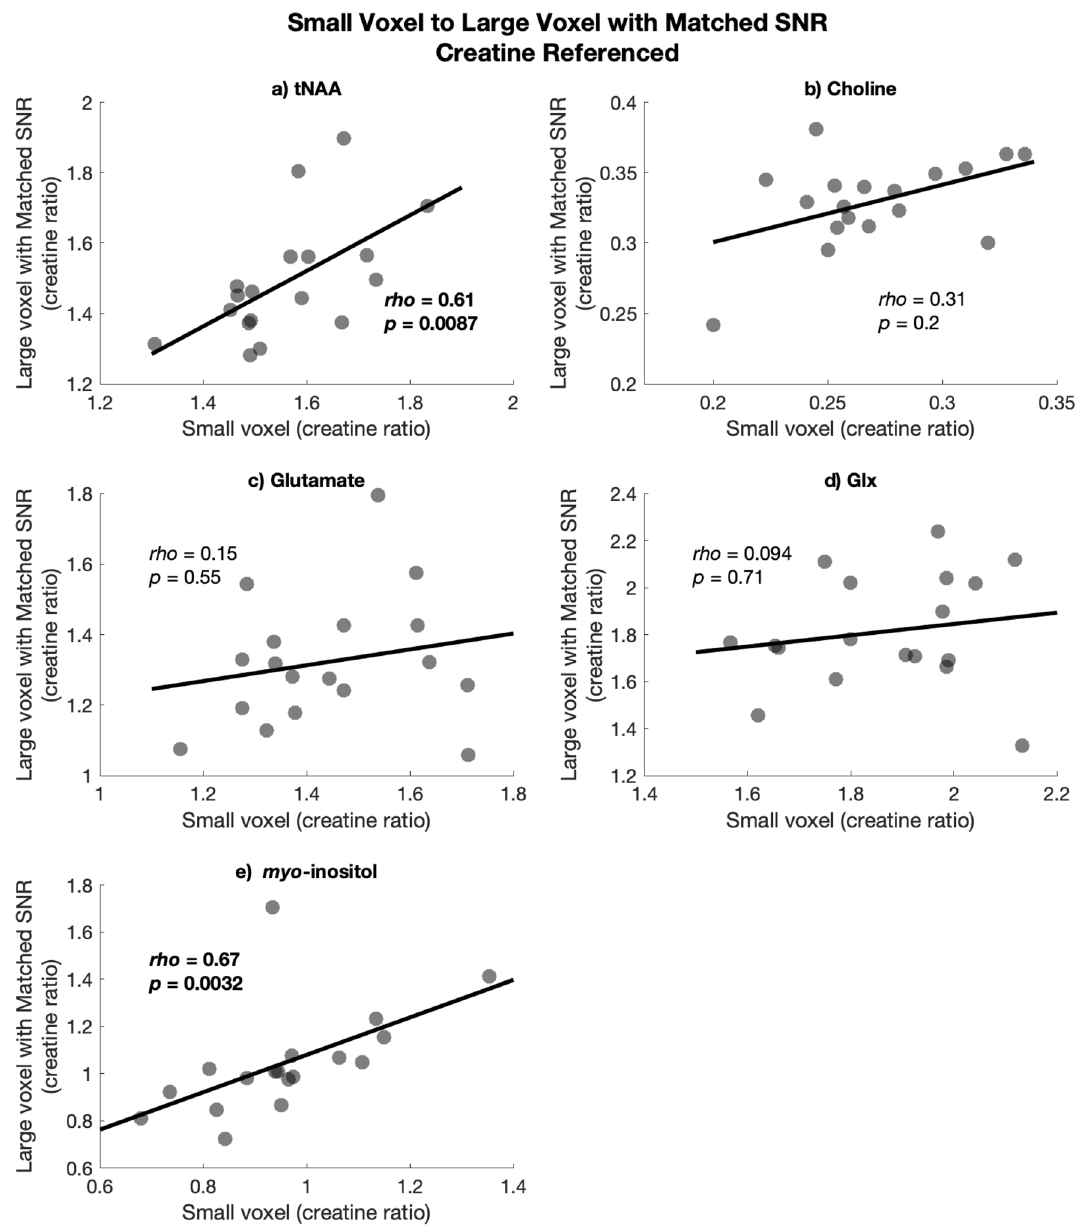
Figure 8. Spearman’s rho correlations between creatine-referenced values in the large voxel with matched SNR on the y-axis and the small voxel on the x-axis for ( a ) tNAA, ( b ) Choline, ( c ) Glutamate, ( d ) Glx, and ( e ) myo-